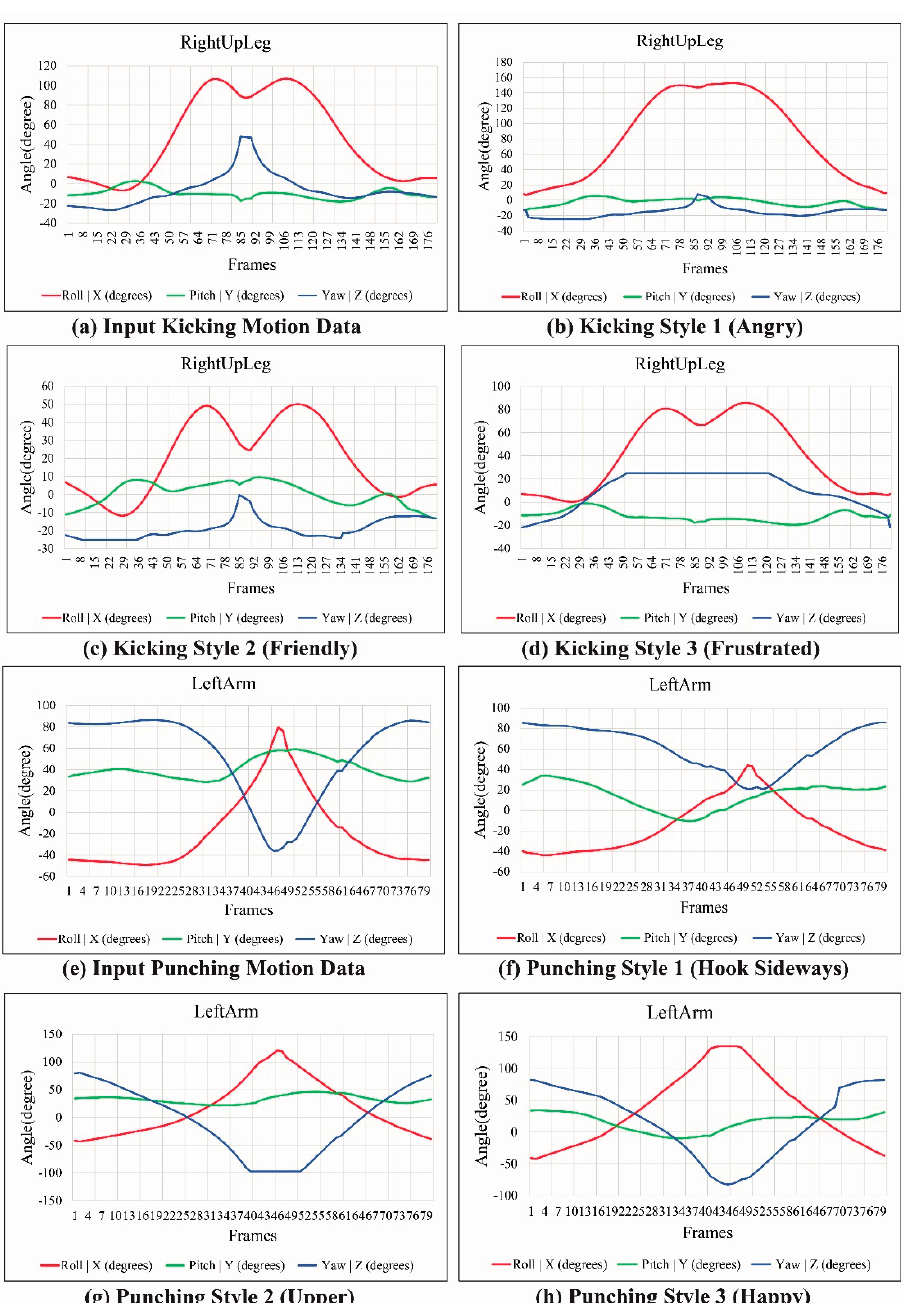
Figure 11. Motion curves of RightUpLeg and LeftArm